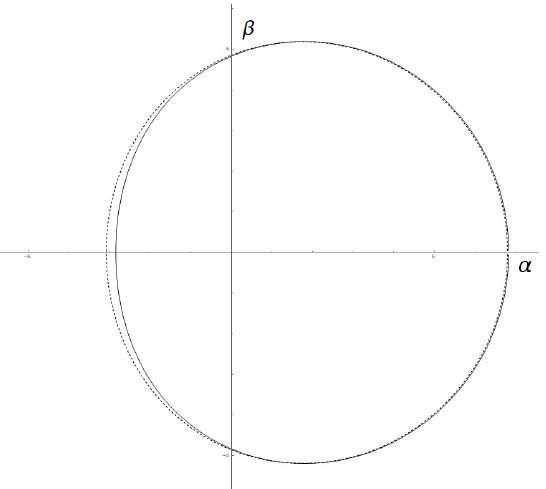
Figure 2. Black holes with the spin equal to a = 0.9 and the following parameters: dashed line corresponds to q = 0.17, C 3 = − 0.5; solid one corresponds to q = 0, C 3 = 0. The rotation axis is directed along the β one; the inclination angle is equal to θ i = − π /2. Reprinted/adapted